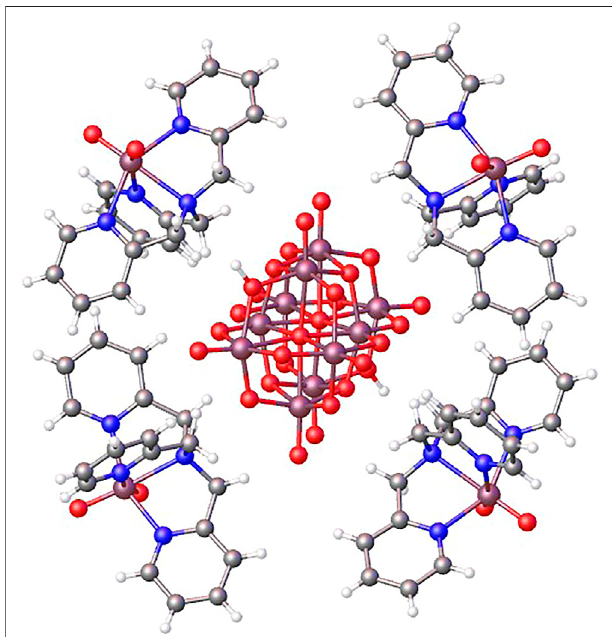
FIGURE 2 | Expansion of asymmetric unit using OLEX program shows the tridimensional structure formed by a diprotonated decavanadate unit and four dioxidovanadium(V) complexes, water molecules were removed for clarity.